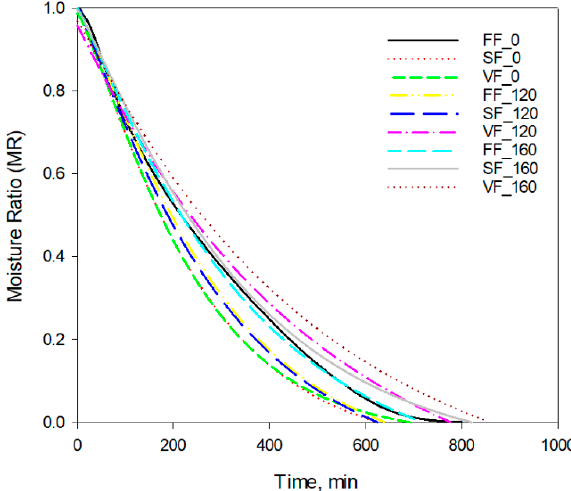
Figure 3. Drying curves predicted based on the Mildilli et al. model.